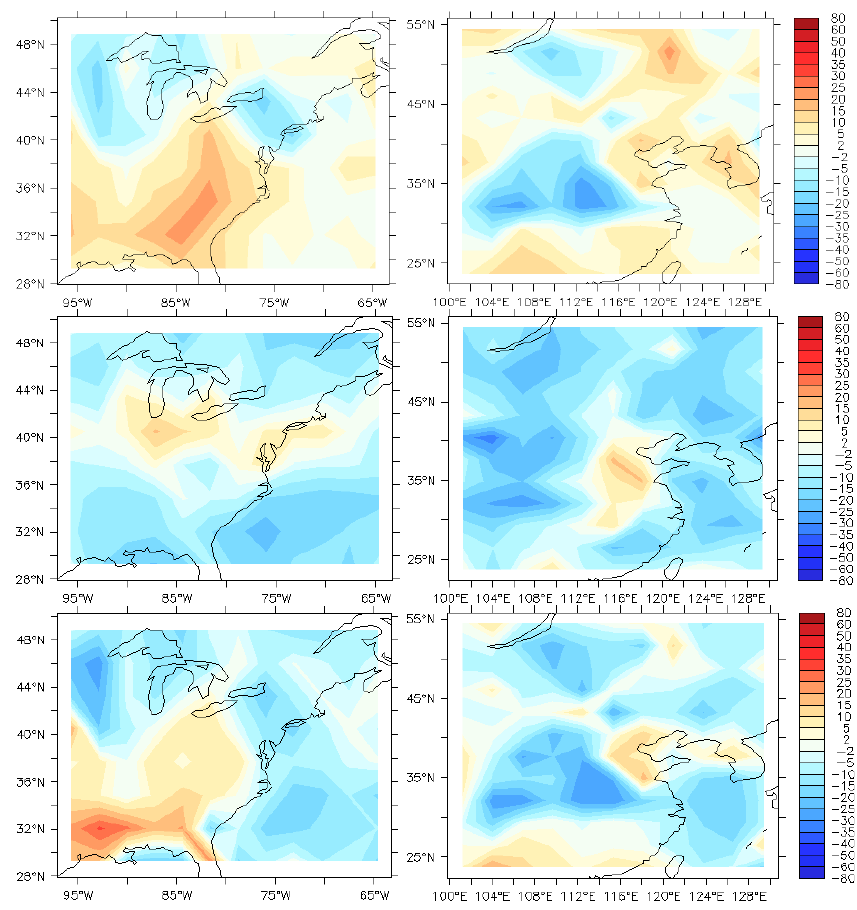
Fig. 6. Simulated monthly average relative changes (%) in the aerosol (coarse soluble mode, cs) sulphates (upper panels), nitrates (middle panels) and ammonium (lower panels) in the reference run (base_S1) near the surface in January over the eastern US (left) and China (right) due to HONO enhancement in the model (S1). Table 1. List of the simulation setups of the different model